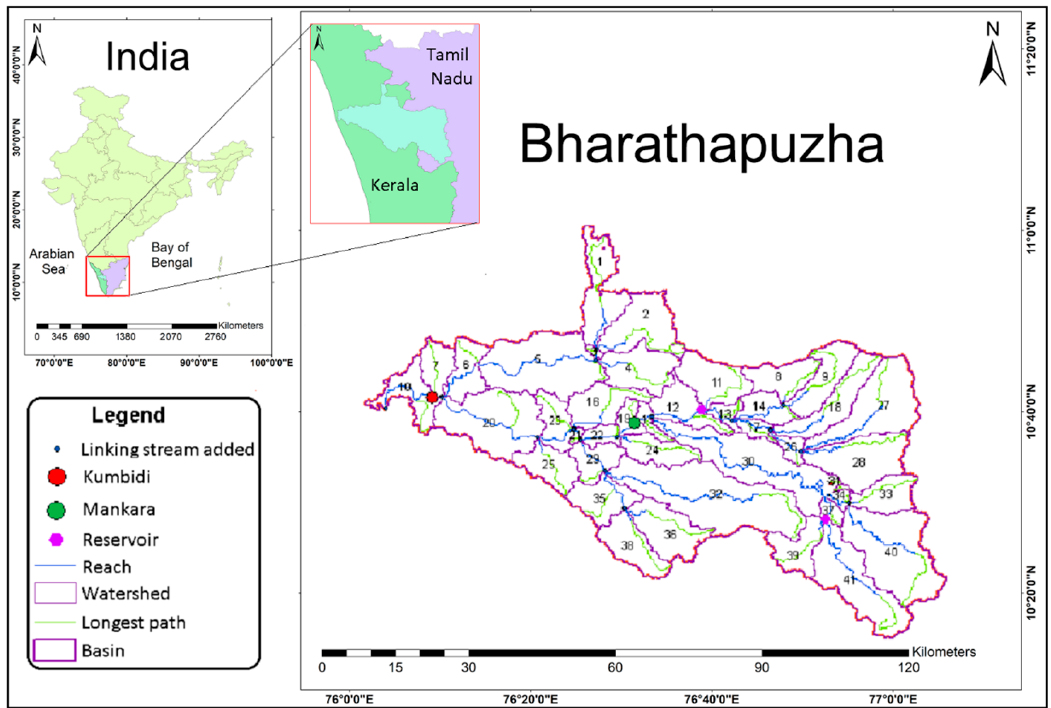
Figure 1. Study area map showing the location of the Bharathapuzha basin, sub-basins, stream networks, and gauging stations (Mankara and